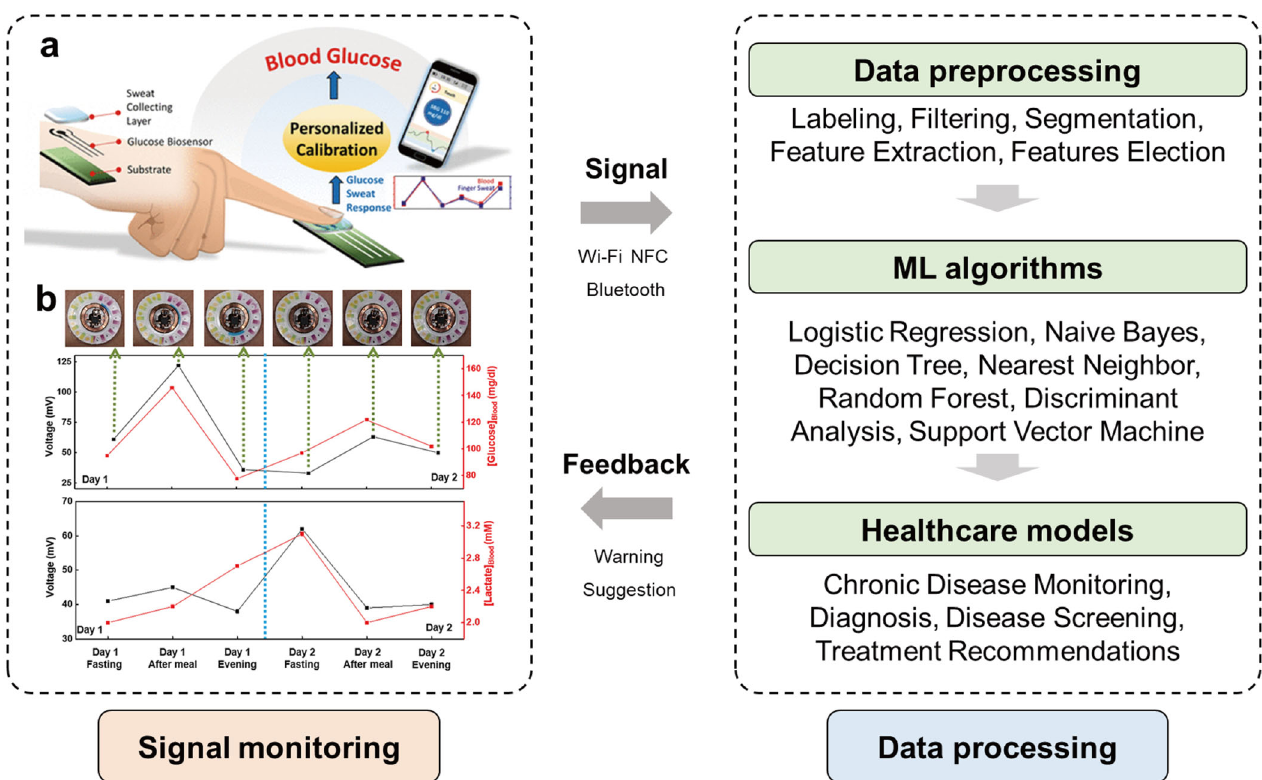
Fig. 7 Application of machine learning in arti fi cial intelligence (AI) biosensors. a Touch-based fi ngertip sweat sensor with an algorithm that can provide personal blood glucose. Ref. 113 , Copyright 2021, American Chemical Society. b Correlation of data acquired from biofuel cell – based glucose and lactate sweat sensors with that acquired from blood glucose and lactate meters. Ref. 114 Copyright 2019, Science